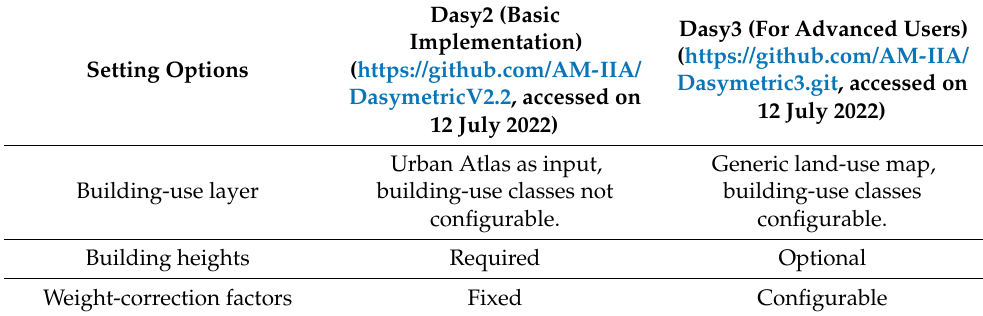
Table 7. Differences in setting options between basic and advanced workflow